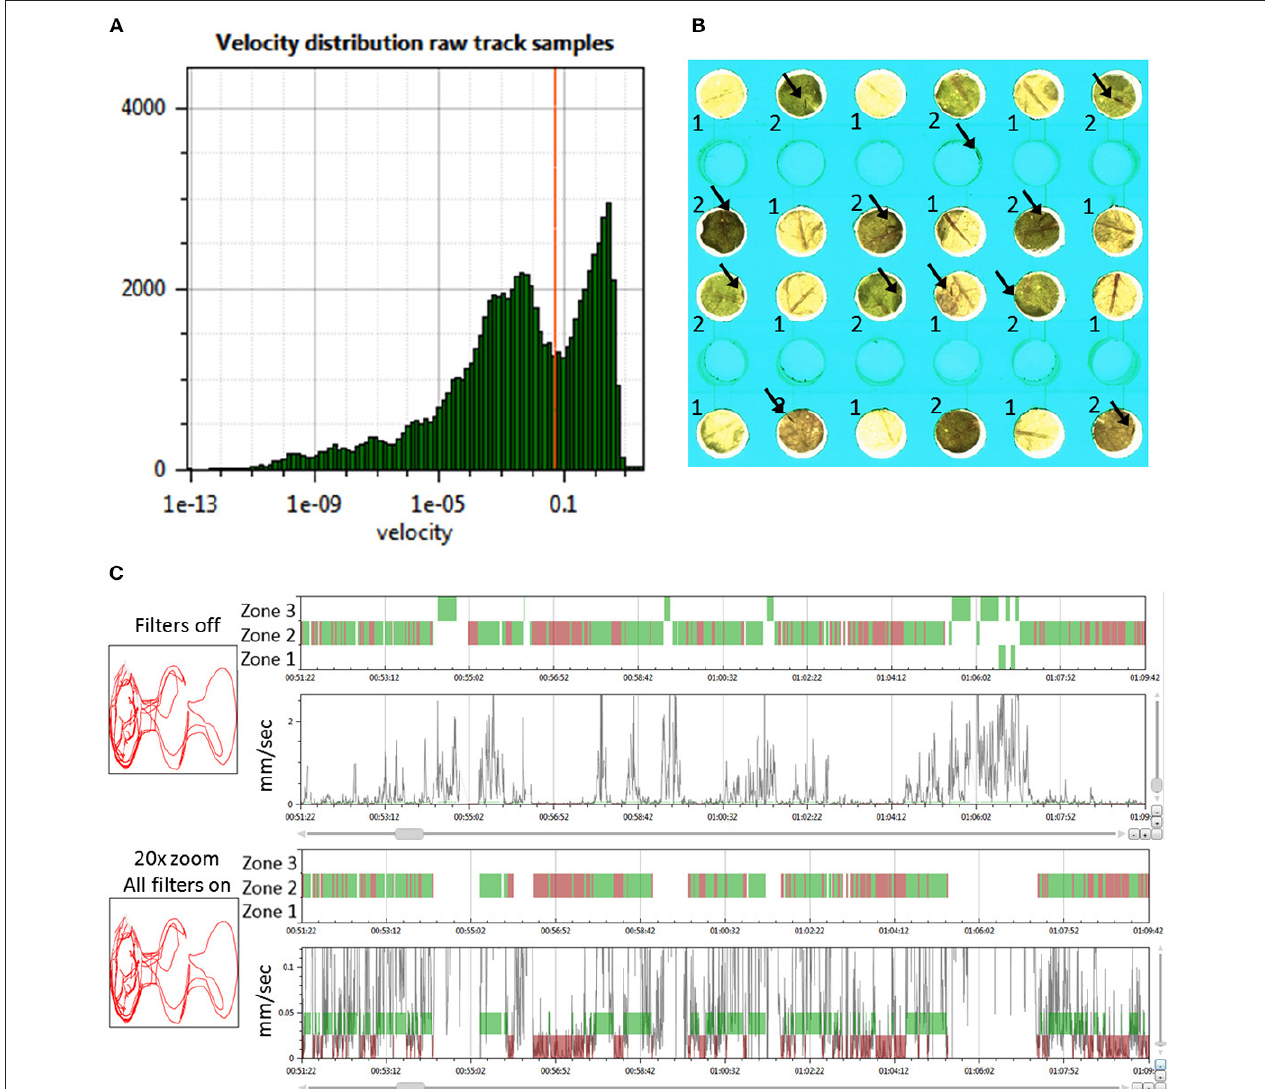
FIGURE 2 | Determining the behavior state and zone position of thrips. (A) Histogram of the velocity distribution of one thrips in a selected arena to aid in selecting proper thresholds for the determination of movement and halting events (velocity in mm/s); (B) Zoom of 12 arenas of the T-maze array with the two Arabidopsis accessions Cur-3 (1) and Rmx-A180 (2) in alternating positions. Arrows indicate the position of thrips individuals. The central empty well provided the access route of thrips from the cage plate below; (C) View on the left of the 2D arena shape position trace (red line) and on the right the 1D thrips zone position (zones 1–3 for Cur-3, Rmx-A180 and other) and velocity traces (black line) and movement state (green band for moving and red for halting) for a selected time interval (ca 18min): thrips per arena are assigned to either a movement or halting state based on the velocity threshold and look-ahead window settings. The second panel is a Y-zoom of the velocity trace. It shows the effects of the velocity threshold (0.05 mm/s) and filters. All movement events in zone 1 and 3 are removed by applying all filters because in those zones they do not start and end with halts within the